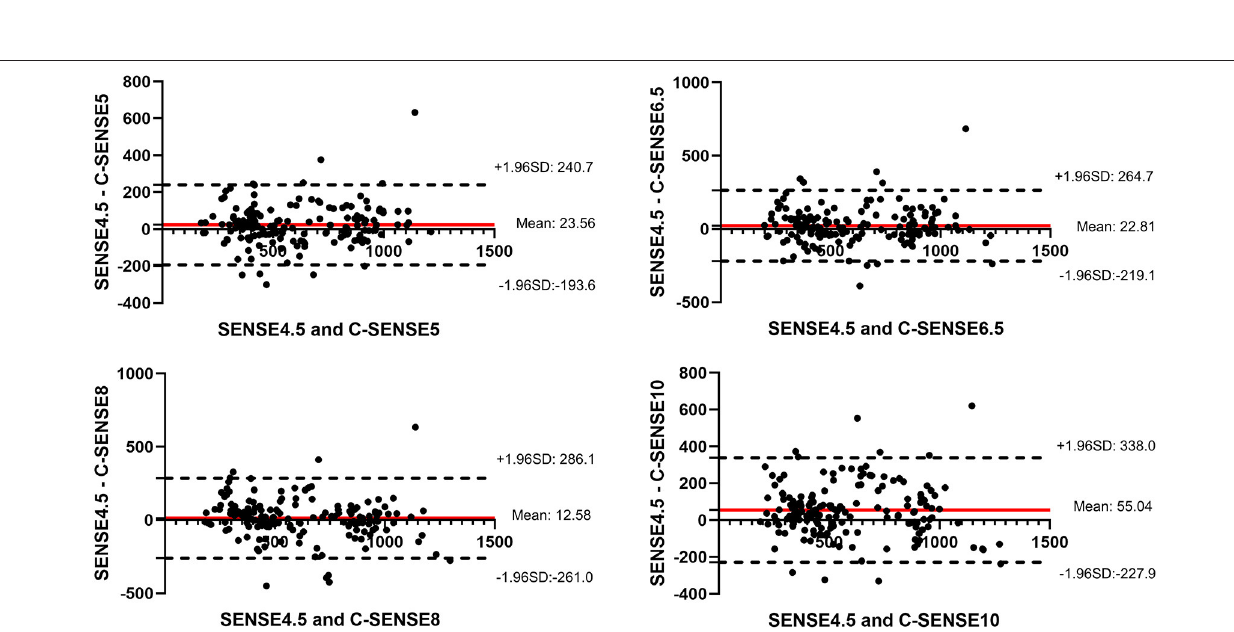
Frontiers in Neurology | www.frontiersin.org